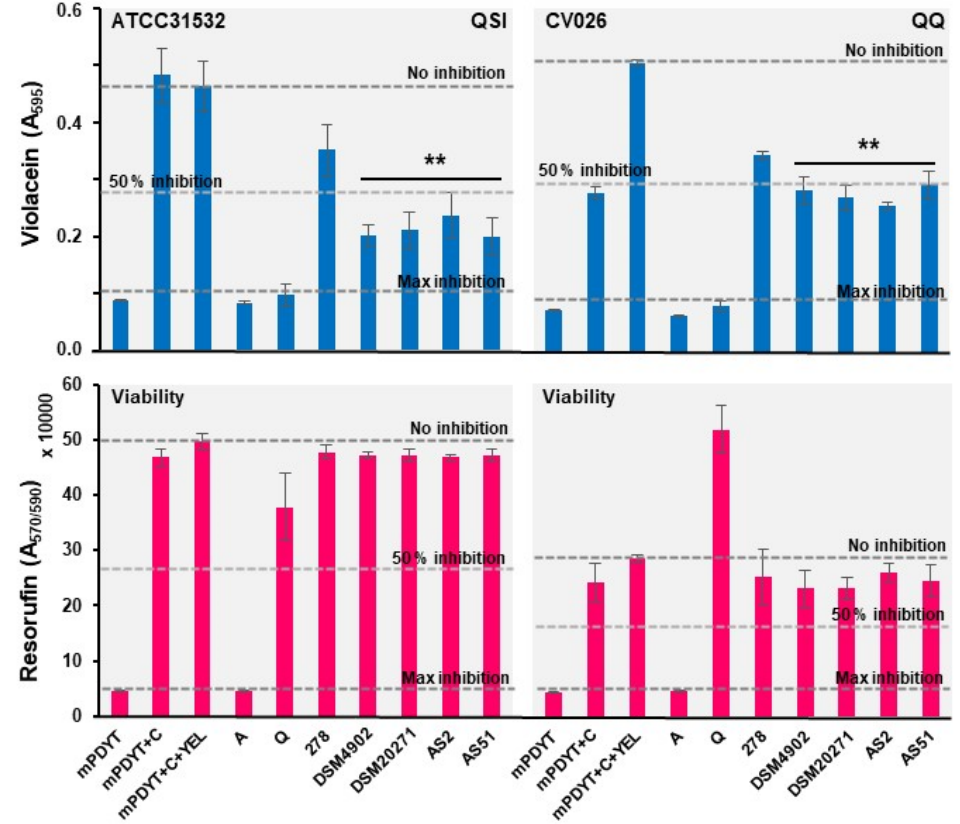
Figure 5. Anti-QS (blue) and bactericidal (pink) activities of the Lactobacillus and Propionibacterium cell-free supernatants against ATCC31532 and CV026. mPDYT, growth media; mPDYT+C, growth medium with ATCC31532 or CV026; A, azithromycin; Q, quercetin. Error bars, ± SD ( n = 3–6). Changes in violacein synthesis in relation to mPDYT+C+YEL: **, p < 0.001. Grid lines, detected violacein levels with/without QS (Q) and bactericidal (A) inhibitors.